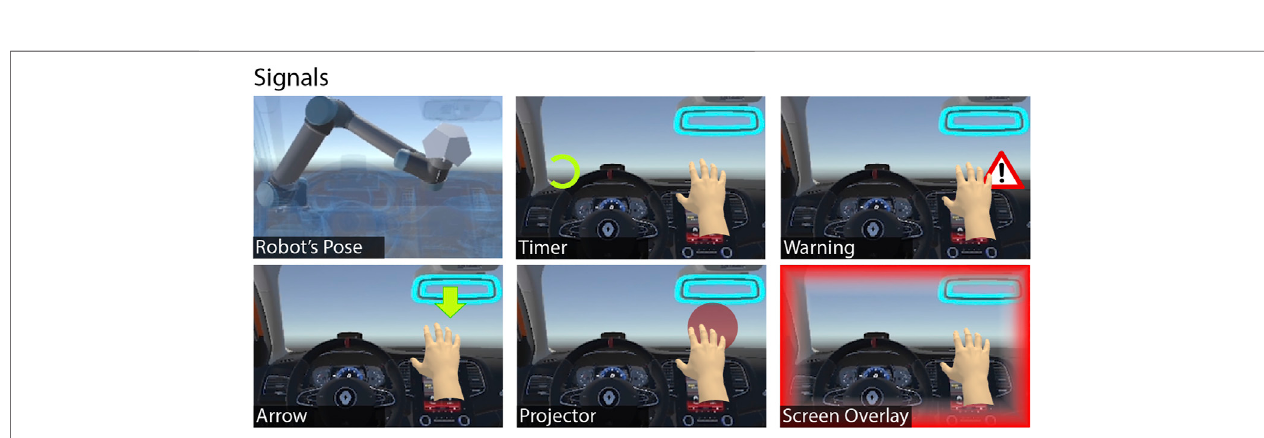
FIGURE 5 | The signals group. This group comprises techniques that use basic signaling metaphors for displaying information about the position of the ETHD ’ s end-effector.